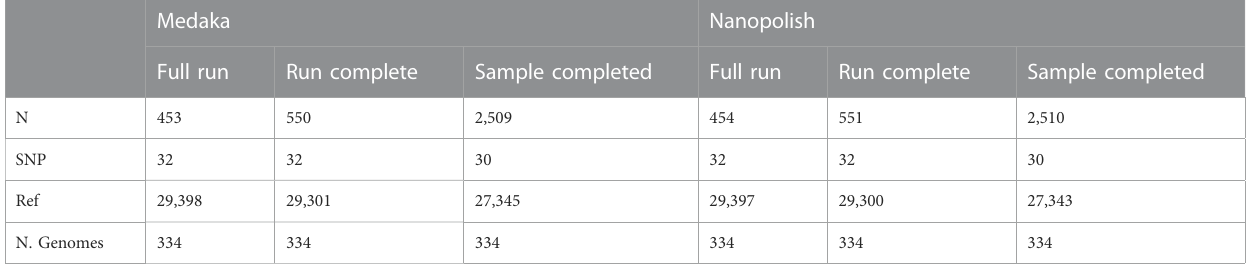
TABLE 2 Contingency table displaying the mean count for sites called as either reference (Ref), SNP or unknown (N), for all three time points (Full Run, Run Completed and Sample Completed), for each SNP calling pipeline. Note, The total of each column, excluding (N. genomes) represents every position in a SARS- CoV-2 genome. Only genomes present in each category (Full Run, Run Completed and Sample Completed) are included in the analysis.